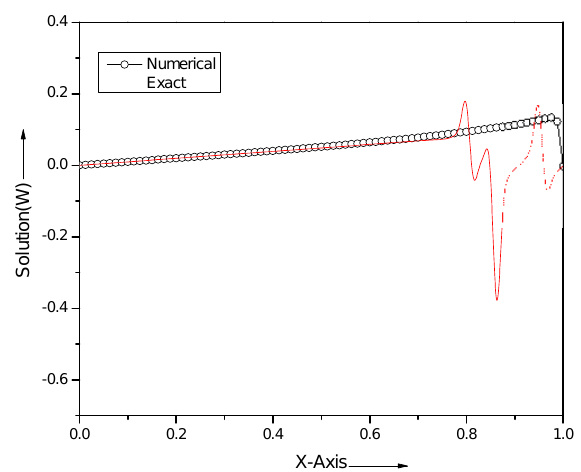
Figure 7. Comparison of analytical and numerical results with ν d = 0.001, ∆ x = 0.0125 and τ = 0.001 at time T = 10 for problem 5.2.